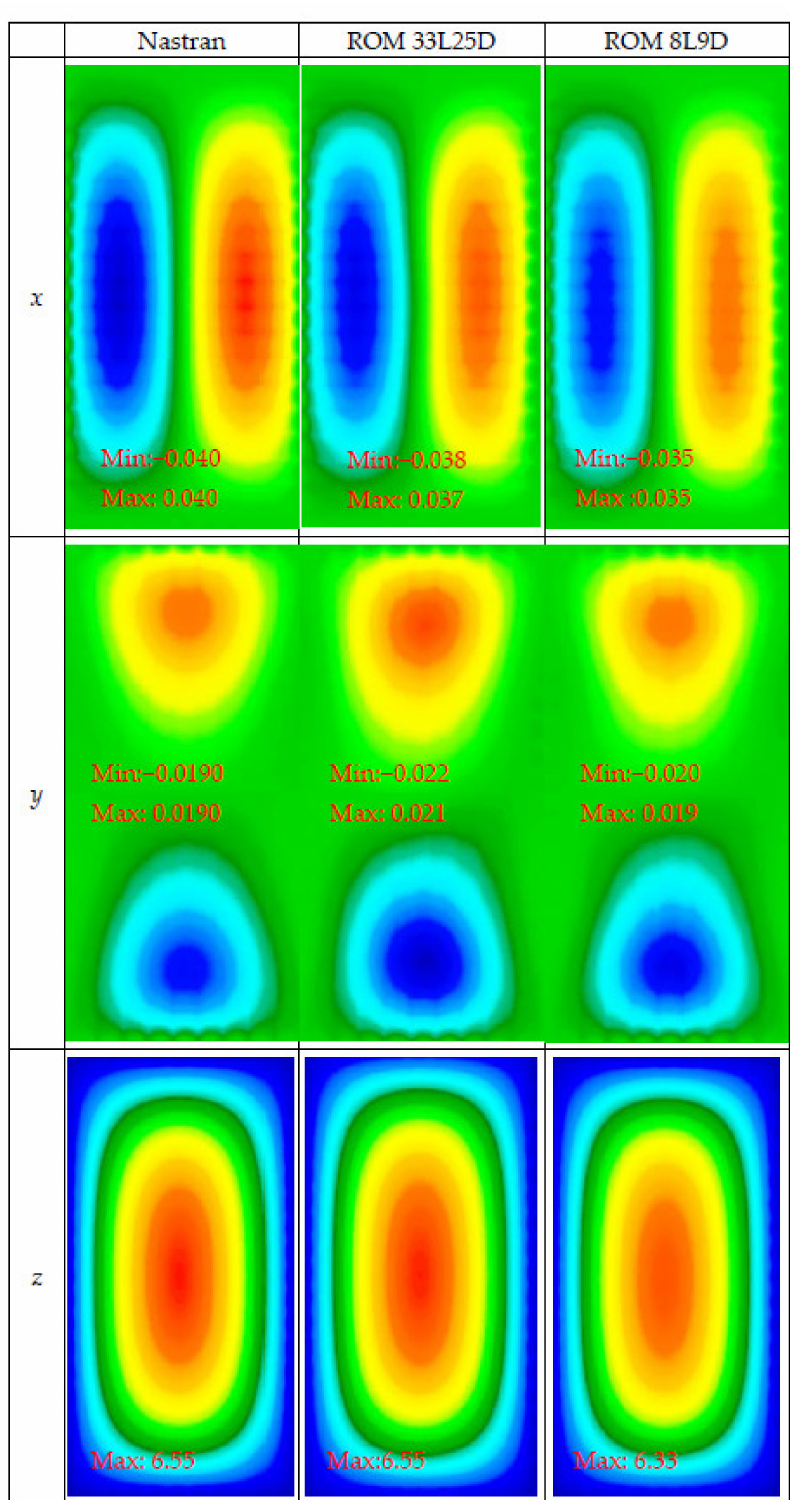
Figure 14. Displacement fields along x , y , and z of the skin predicted by Nastran and by the 33L25D and 8L9D ROMs in units of thickness. Uniform pressure of magnitude +20